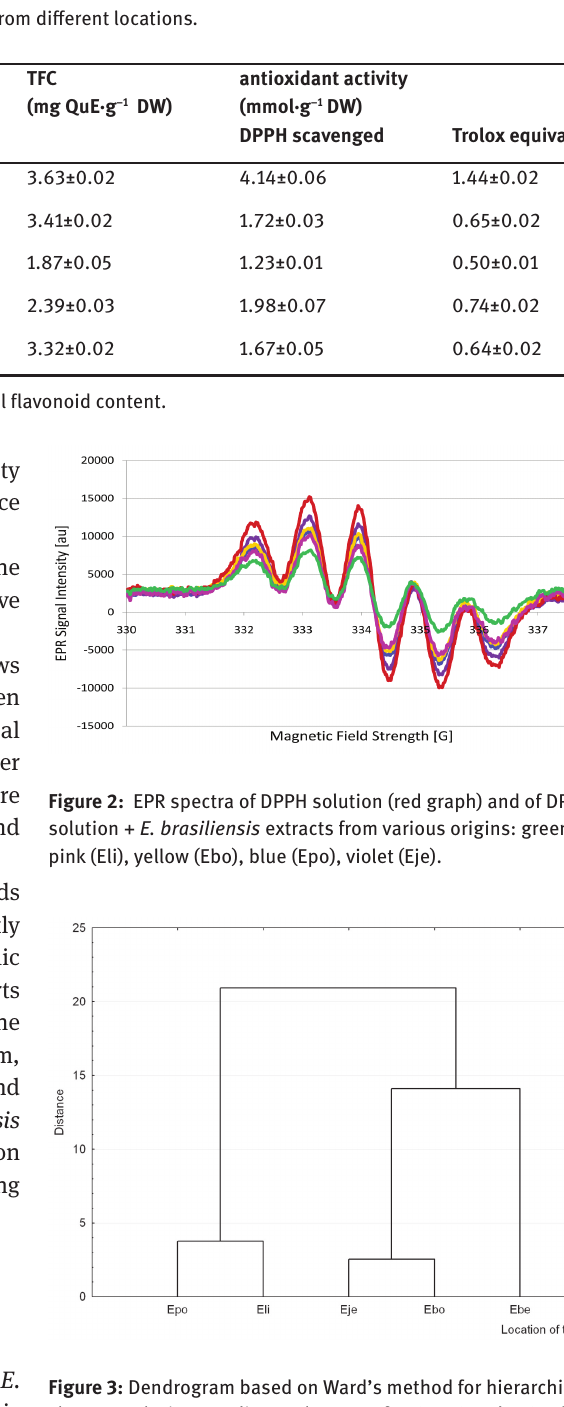
Figure 3: Dendrogram based on Ward’s method for hierarchical cluster analysis according to the sum of TPC, TTC and TFC values in analyzed